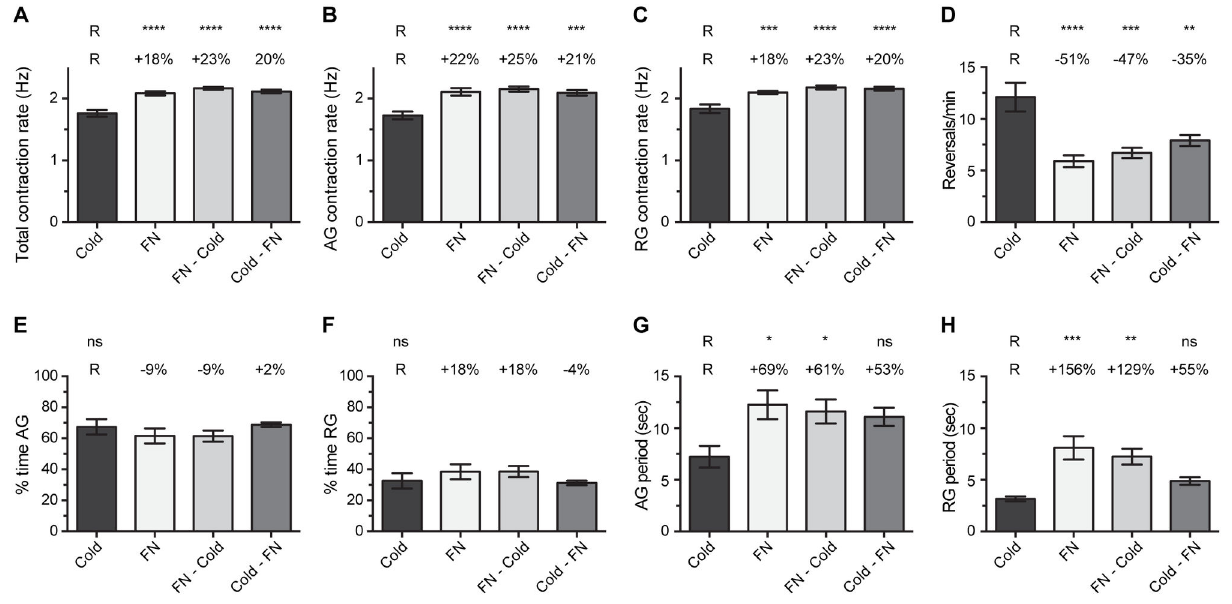
Figure 3. Effect of combining modes of anesthesia on heart physiology. Four groups were assayed: (1) 60 sec cold anesthesia; (2) 30 sec FlyNap (FN) anesthesia; (3) FlyNap anesthesia immediately followed by cold anesthesia; (4) cold anesthesia immediately followed by FlyNap anesthesia. The following heart parameters are reported: (A–C) total, anterograde and retrograde contraction rate; (D) frequency of heartbeat directional reversals; (E–F) percent time contracting in the anterograde and retrograde directions; (G–H) anterograde and retrograde period lengths. The data were analyzed by one-way ANOVA, and when P<0.05 the statistical significances between the cold anesthesia group (R, reference group) and the other groups are denoted using asterisks (Tukey’s multiple comparisons post-hoc test: ns, P>0.05; *, P<0.05; **, P<0.01; ***, P<0.001; ****, P<0.0001). The percentages reported above the columns report the percentage difference between that group and the cold (R) group. Bars denote the standard error of the mean. For all groups, N =